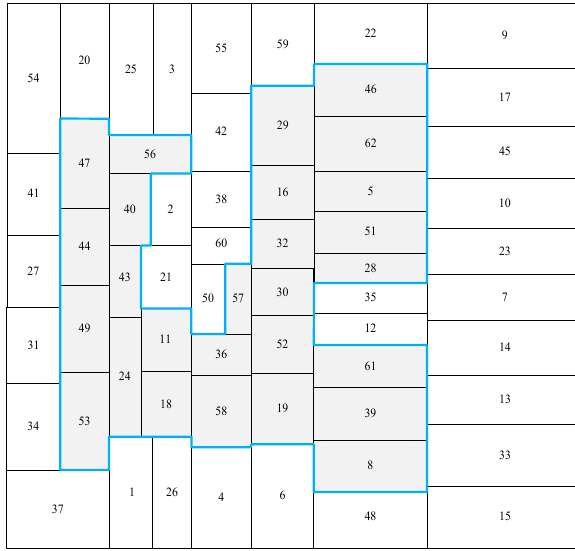
Figure 15. Layout configurations. ( a ) SC30; ( b ) SC35.